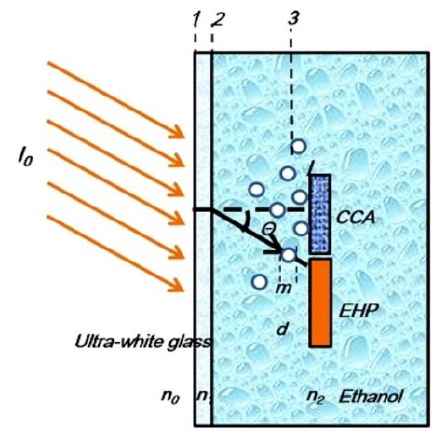
Figure 13. The model of bubble effect on light (CCA: Concentrator Cell Assembly; EHP: Electric Heating Plate) [79].